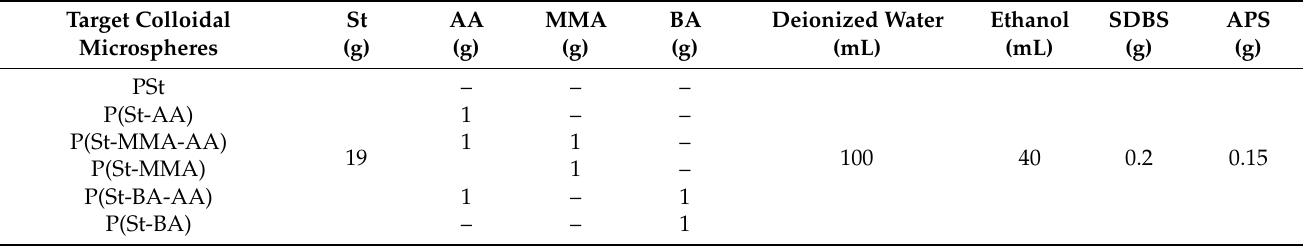
Table 1. Experimental details of different polystyrene (PSt)-based colloidal microspheres synthesized by emulsion polymer- ization. Target